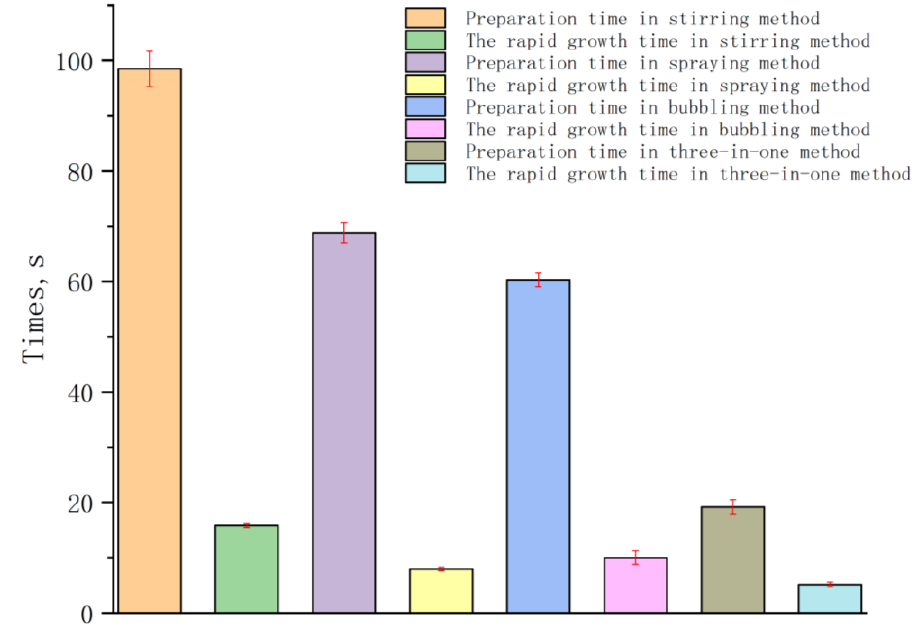
Figure 16. Comparison of average preparation time and induction time in methods of stirring, spraying, bubbling, and three-in-one. The error is calculated according to the standard deviation of experiment 1 and 2.